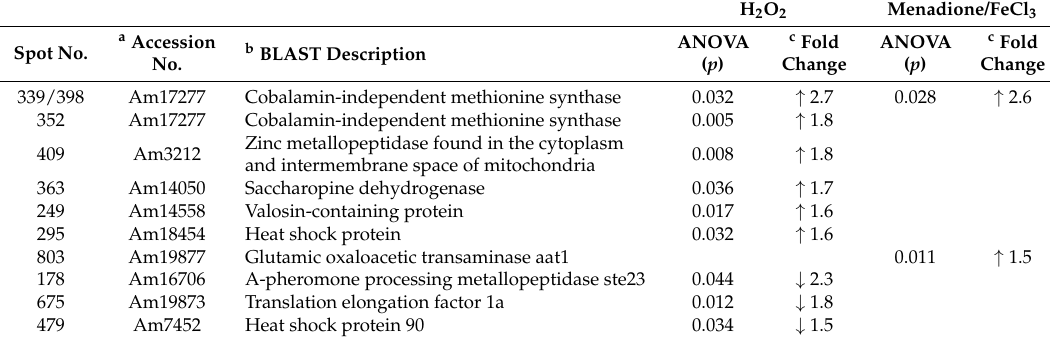
Table 1. Details of unambiguously-identified A. mellea mycelial proteins found to be differentially abundant following H 2 O 2 or menadione/FeCl 3 -induced oxidative stress for 3 h. Proteins from 2-DE identified by SameSpots™ software, analysed by LC-MS/MS with subsequent interrogation of the A. mellea cDNA database. H 2 O 2 Menadione/FeCl 3 b BLAST Description Spot No. No.